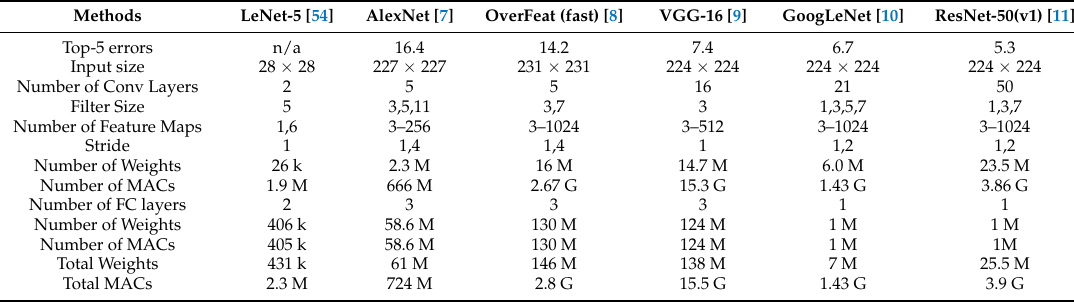
Table 2. The top-5% errors with computational parameters and macs for different deep CNN models.